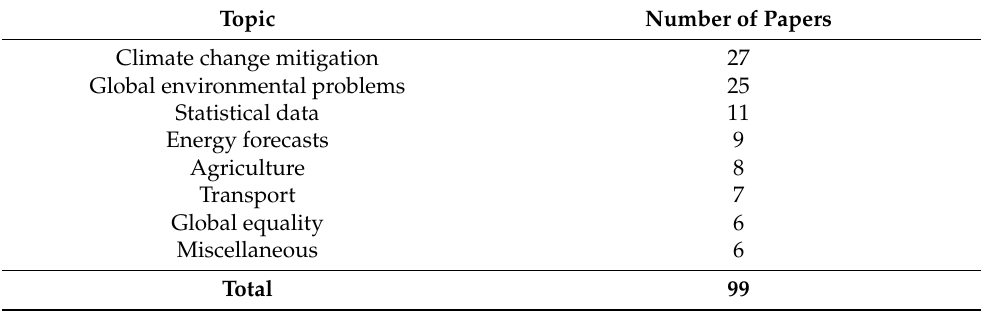
Table 1. Breakdown of the 99 papers covered in this review. Topic Number of